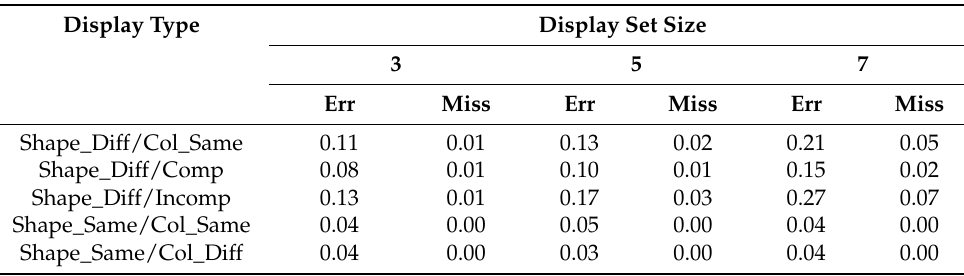
Table 2. Average error and miss rates (expressed as proportions) for the conditions of interest in Experiment 2.